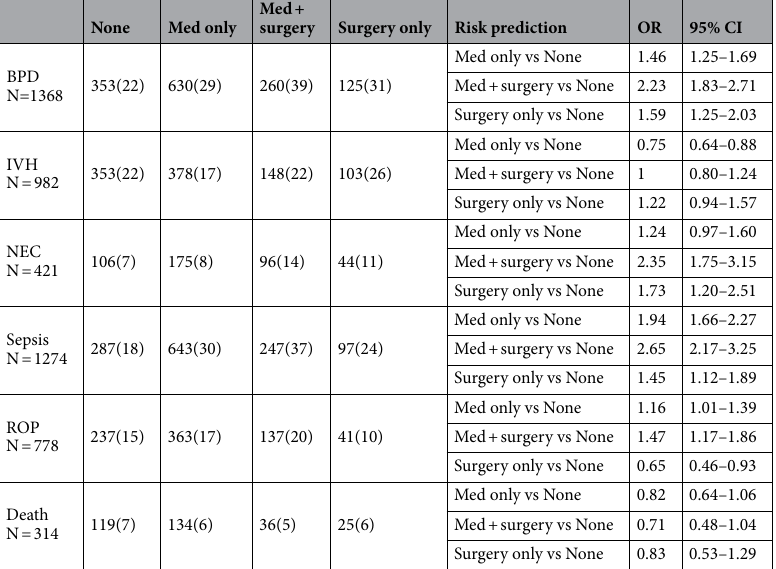
Table 2. Risk analysis for the morbidities according to the treatment strategy. Data are shown as number (%). Abbreviations: BPD, bronchopulmonary dysplasia; IVH, intraventricular hemorrhage; NEC, necrotizing enterocolitis; ROP, retinopathy of prematurity; Med, medication; OR, odds ratio; SD, standard